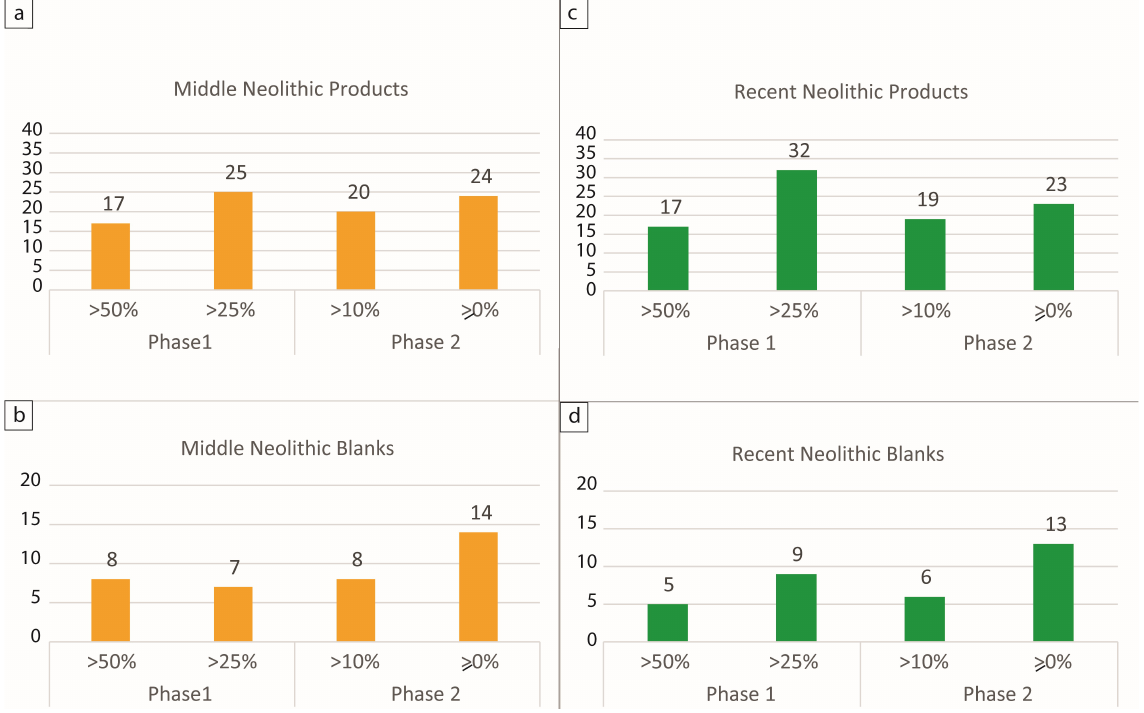
Figure 4. Middle Neolithic and Late Neolithic proportions of products and blanks by percentage of natural surface area.